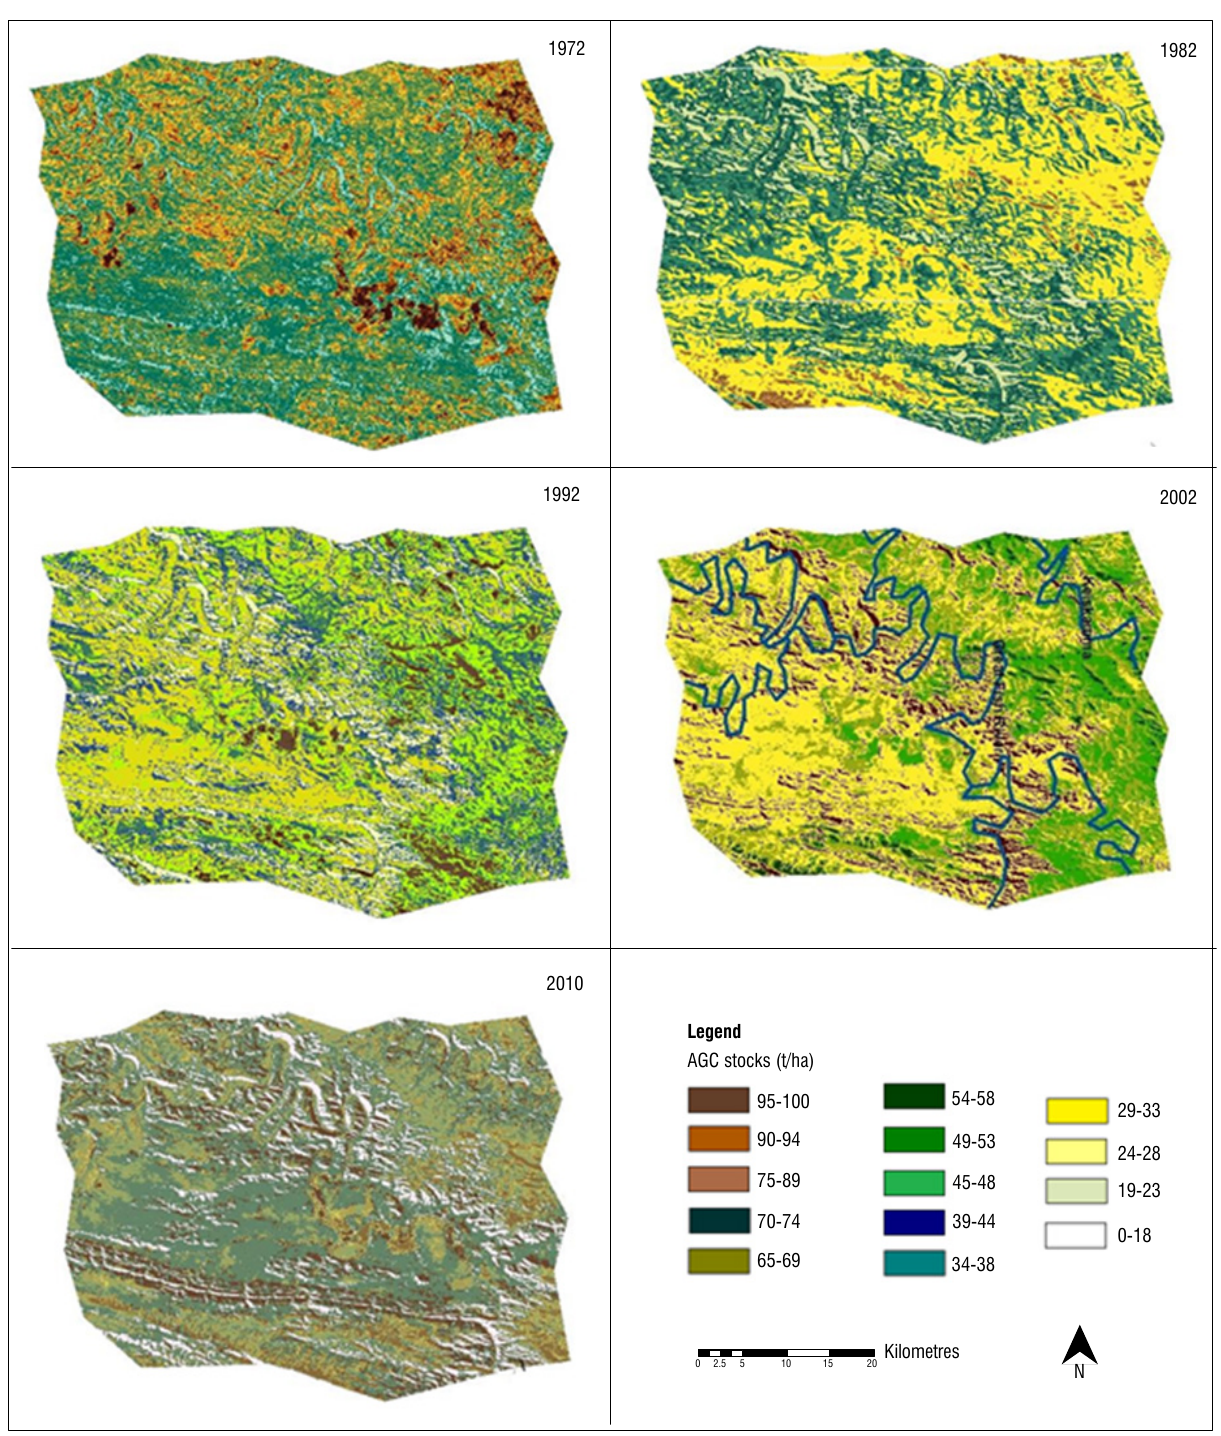
Figure 4: Aboveground carbon (AGC) stock changes between 1972 and